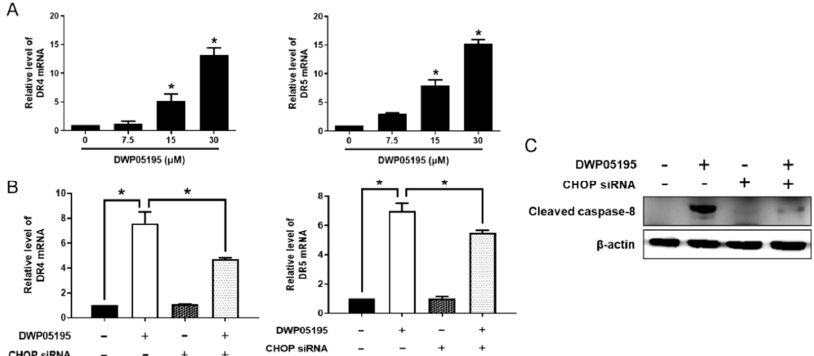
Figure 5. Involvement of CHOP in DWP05195-stimulated extrinsic apoptosis pathway. ( A ) A2780 cells were treated with 0, 7.5, 15, and 30 μ M DWP05195 for 24 h. Death receptor 4 (DR4) and death receptor 5 (DR5) levels were determined by real-time RT-PCR. * p < 0.05 compared with control. ( B ) After the CHOP knockdown, DR4 and DR5 levels were detected by real-time RT-PCR and ( C ) cleaved caspase-8 levels were detected by Western blotting. Uncropped blots of Figure 5C are shown in Figure S1 Results are representative of at least three independent experiments. * p < 0.05.